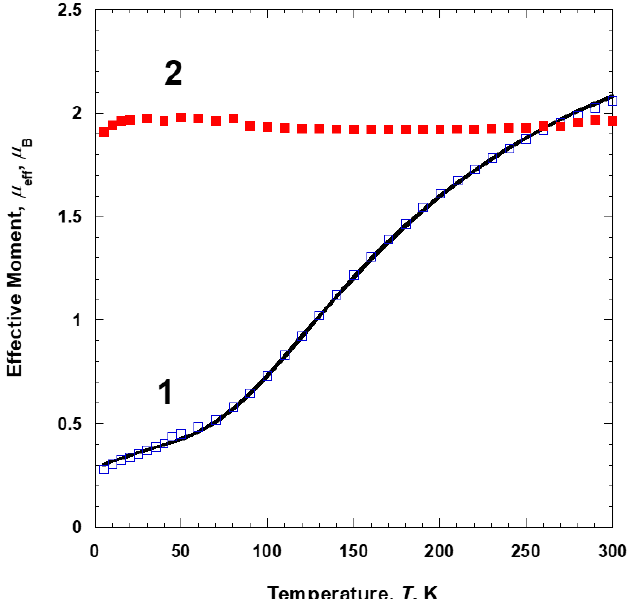
Figure 8. Temperature-dependence of the magnetic moments of polymers 1 ( □ , blue) and 2 ( ■ , red). The solid line represents a best fit of the data as described in the text.